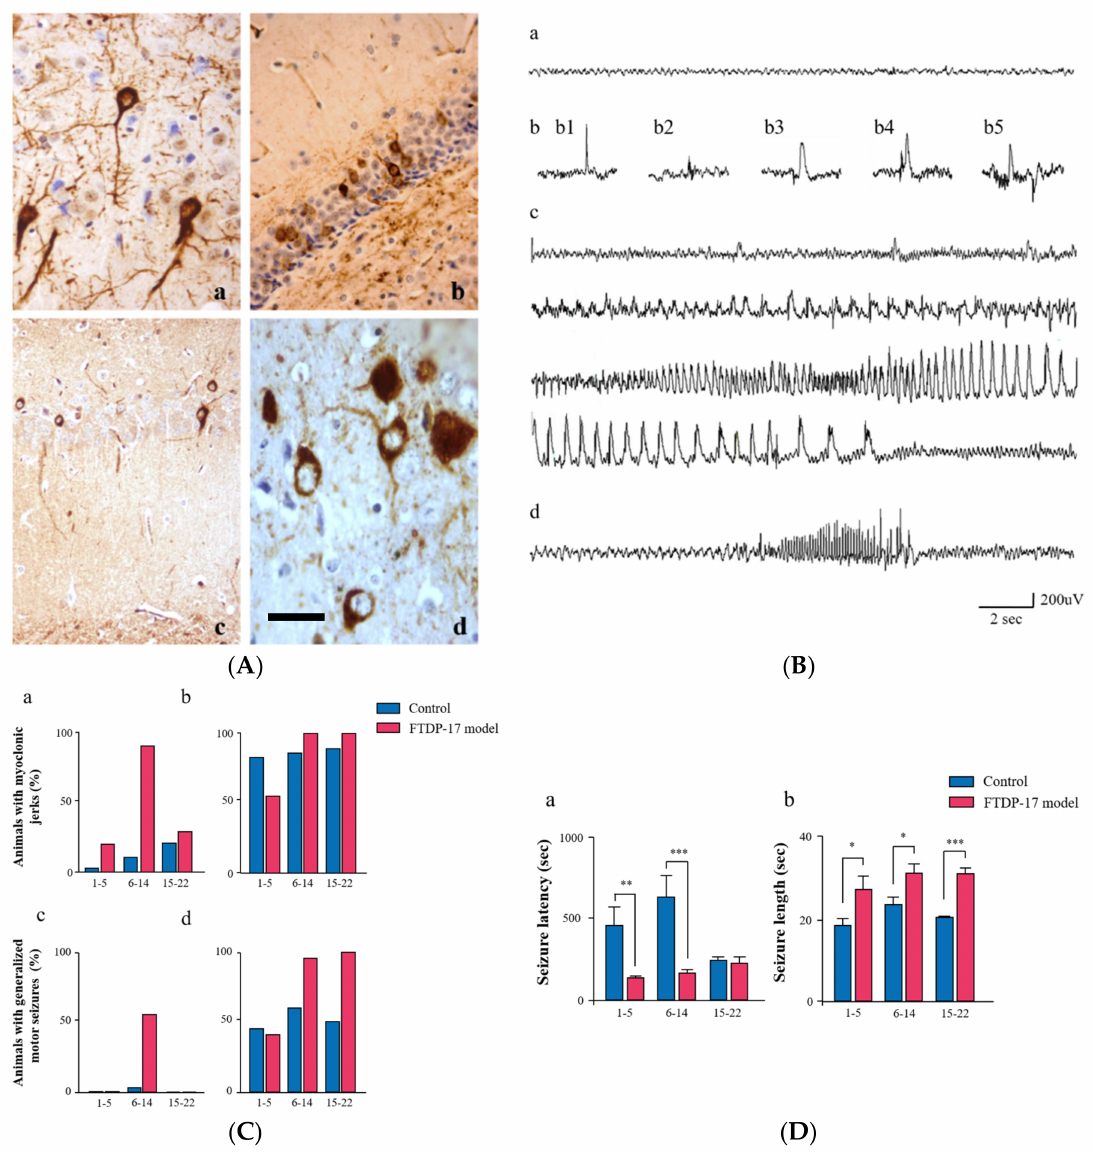
Figure 1. The expression of human TauVLW transgene in FTDP-17 mouse model causes many of the neurological and behavioral abnormalities found in patients with FTDP-17. ( A ) Examples of hyperphosphorylated tau aggregates in brain of FTDP-17 mice at 18 months of age. AT8 tau aggregates in neurons of (a) the CA3 and (c) the CA1 region of the hippocampus; PHF1 tau aggregates in (b) dentate gyrus and (d) amygdala (scale bar corresponds to 32 um in (a), 52 um in (b, c) and 28 um in (d)). ( B ) FTDP-17 mice show epileptic activity. (a) Intracranial record of background activity in control mice; (b) interictal activity, (b1) spike, (b2) polyspike, (b3,4) spike and wave and (b5) polyspike and wave complexes. ( C ) FTDP-17 mice have a higher sensitivity to the PTZ epileptogenic agent. The percentages of mice showing PTZ-induced myoclonic jerks (a and b) and generalized seizures (c and d) are higher in FTDP-17 mice than in controls. ( D ) Seizures induced by PTZ in FTDP-17 mice are more severe than those in control mice. The latency for PTZ-induced seizure onset is shorter (a) and the length of seizures is longer (b) in FTDP-17 mice compared to control mice. * p < 0.05; ** p < 0.01; *** p < 0.001 ( n =